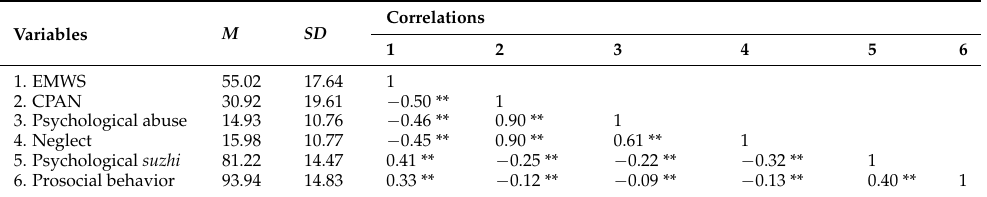
Table 1. Means, standard deviations, and correlations among all variables (N = 948).